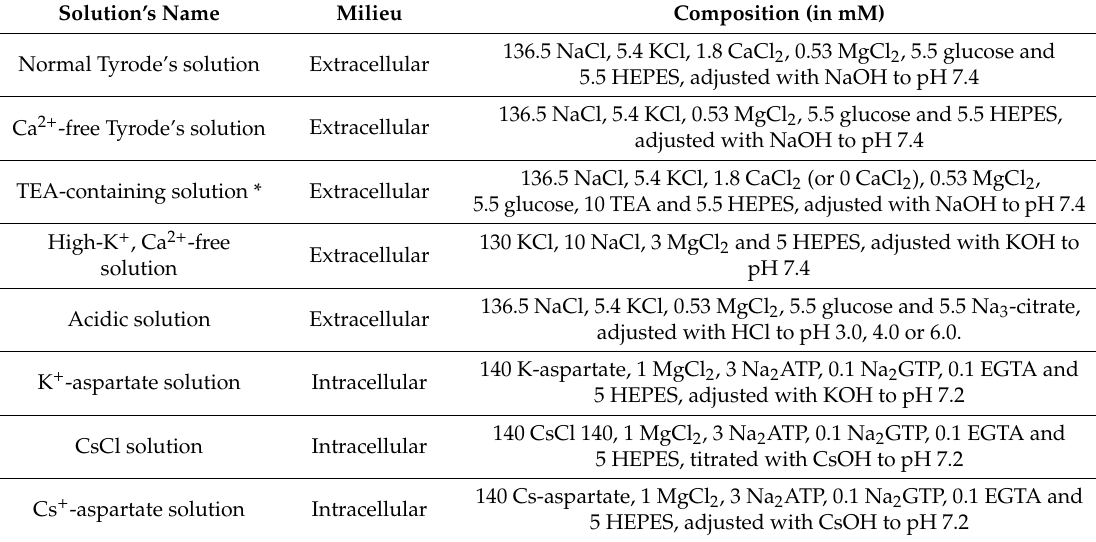
Table 1. The composition of extracellular and intracellular solutions used in this